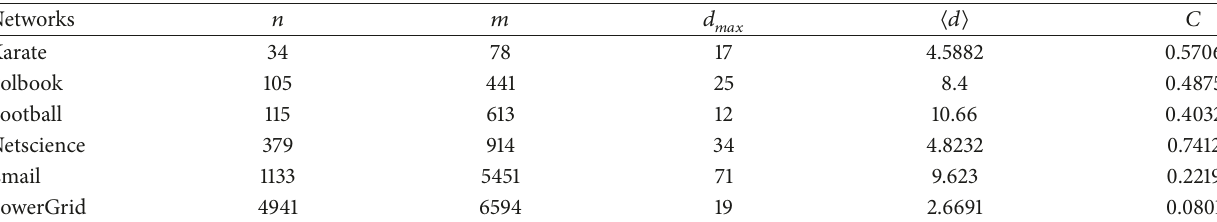
Table 3: Some statistical properties of real